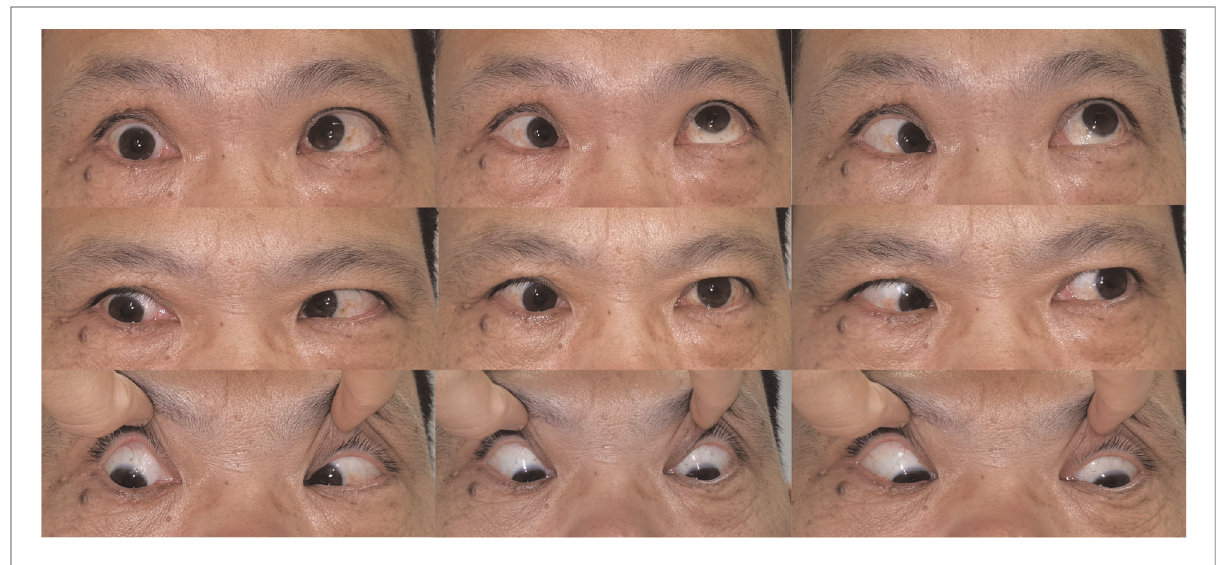
FIGURE 3 Clinical photograph showing Patient 3 with restricted esotropia and katotropia at a 15-month